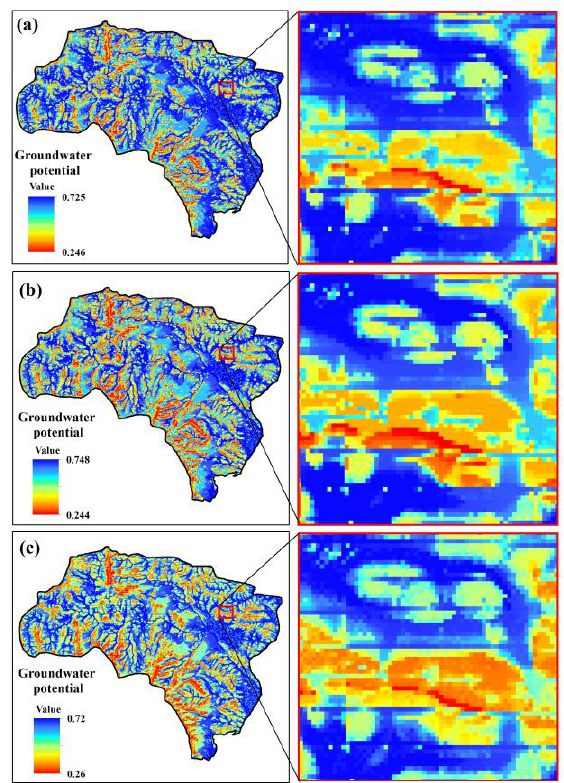
Figure 5. Groundwater potential maps produced by GARP and three sample datasets ( a – c ).